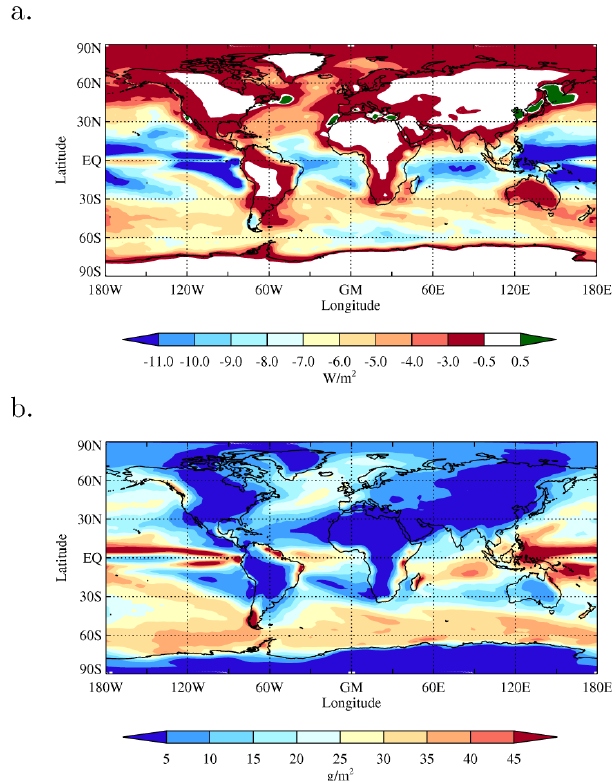
Fig. 4. NorESM: (a) change in TOA radiative flux (Wm − 2 ) due to aerosol-cloud interactions, (b) change in cloud liquid water path (gm − 2 ). Both annual